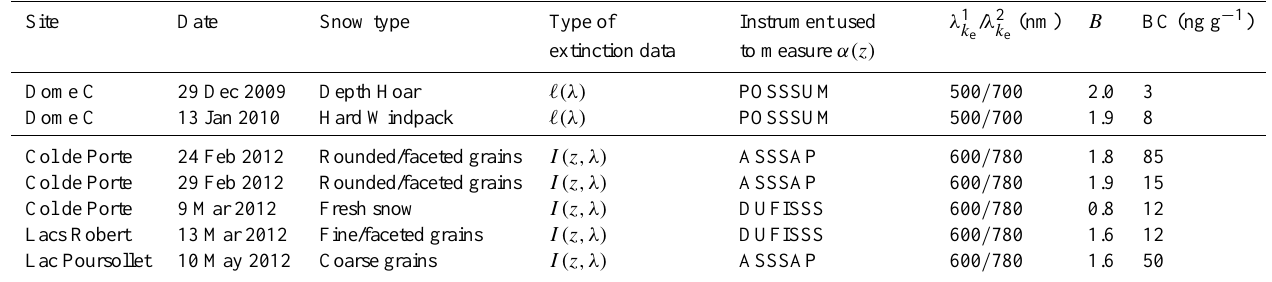
Table 2. Summary of the measurements collected at Dome C and in the Alps. λ 1 described in Sect. 4.1. The retrieved values of B and black carbon contents are